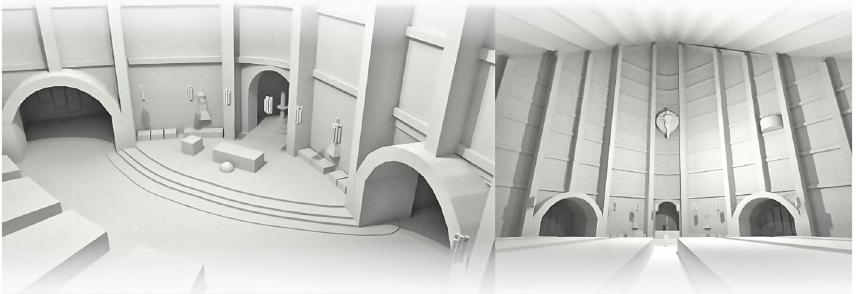
Figure 5. Bird-eye view onto the presbytery area and a view one side of the church towards the altar